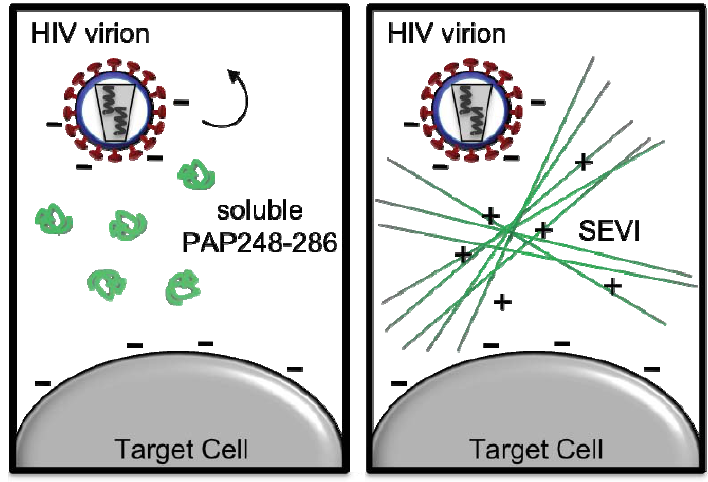
Figure 2. Semen derived Enhancer of Viral Infection (SEVI) amyloid fibrils augment HIV infectivity. In the non-amyloid form, soluble PAP248-286 has no effect on HIV infectivity, and electrostatic repulsion between the membranes of HIV virions and target cells limits the ability of virions to interact with target cells (left). Once assembled into amyloid fibrils, SEVI’s network of positive charges neutralizes this electrostatic repulsion, and SEVI fibrils capture HIV virions to promote cell attachment and fusion, thereby enhancing HIV infectivity